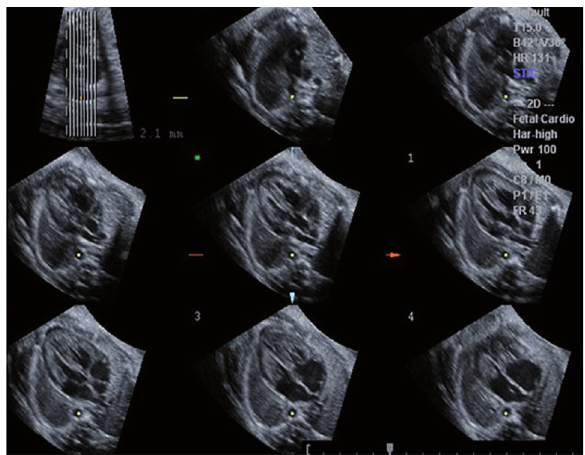
Fig. 2 - Use of TUI with simultaneous visualization of sequential axial planes of the fetal chest at heart level (3VT, 5C, 4C). TUI: tomographic ultrasound imaging. 3VT: three vessels and trachea; 5C: five chambers; 4C: four